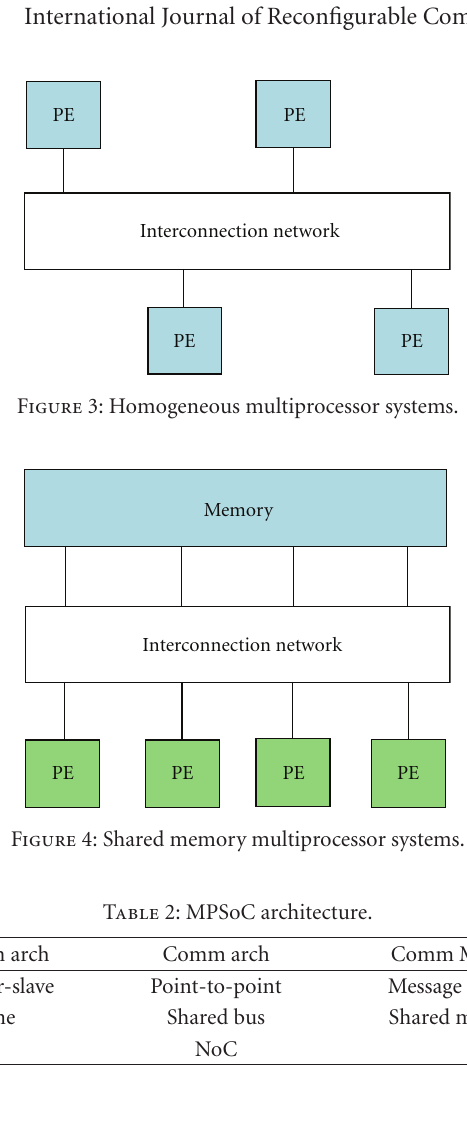
figurable systems. Run-time reconfigurable systems